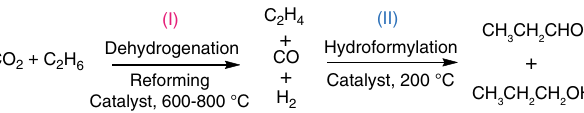
Fig. 1 Reaction scheme of the production of C3 oxygenates from the upgrading of CO 2 and ethane. Ethylene and syngas are produced from the fi rst reactor via the CO 2 -assisted dehydrogenation and reforming of ethane and subsequently used for the hydroformylation reaction in the second reactor to produce propanal and/or